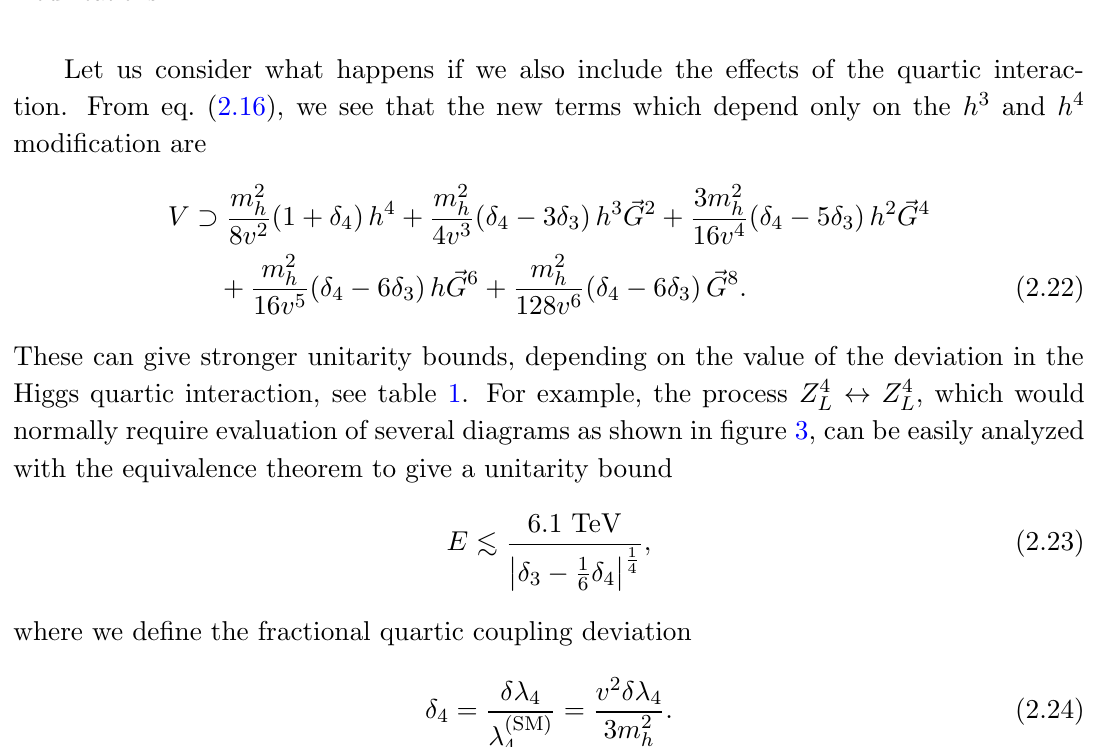
Table 1 . Unitarity violating amplitudes that only depend on the trilinear and quartic Higgs